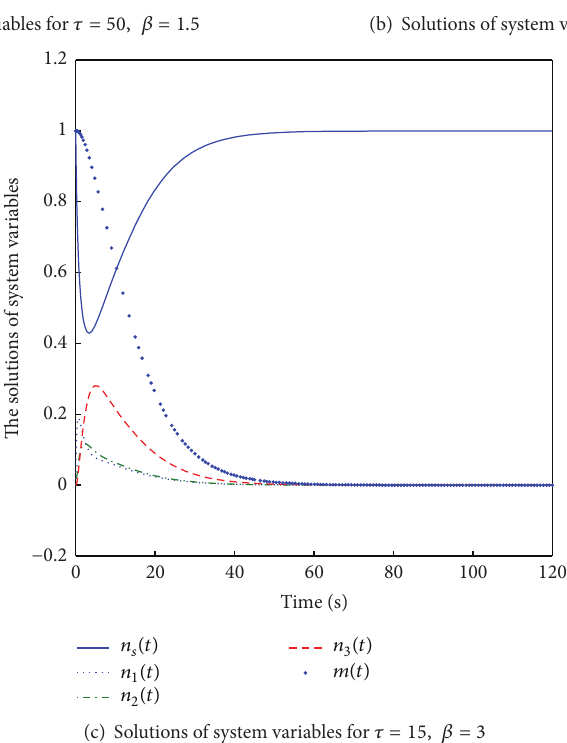
Figure 4: The evolution of the system variables of cooperative hunting